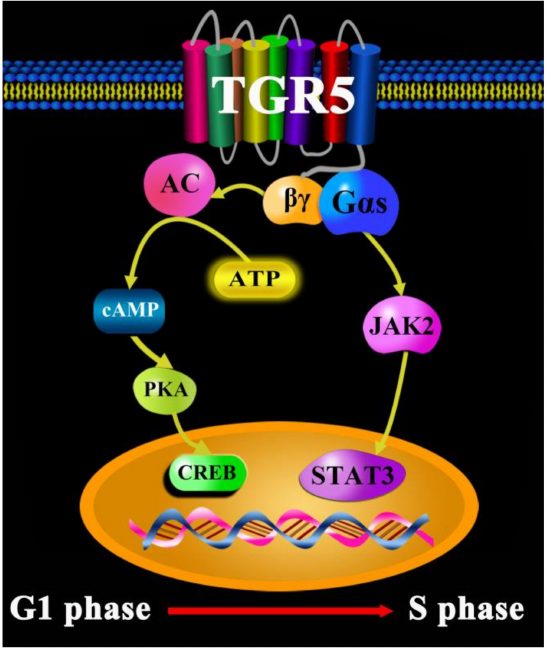
Figure 3. TGR5 in lung